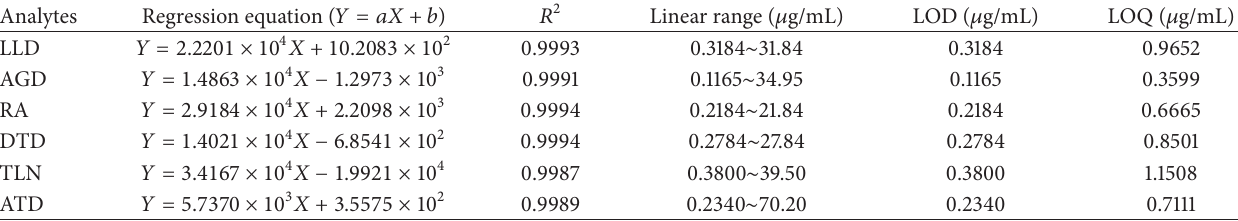
Table 3: Regression data, LODs, and LOQs for the six active constituents.